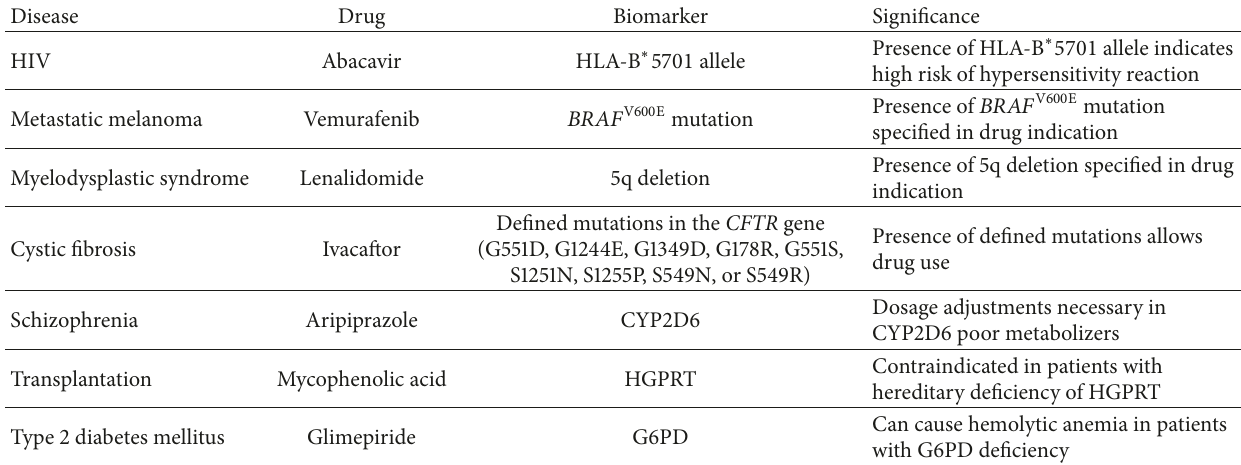
Table 3: Examples of pharmacogenetic biomarkers in clinical